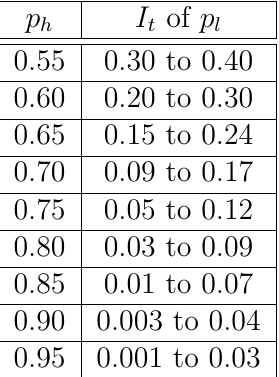
of p for each p t l